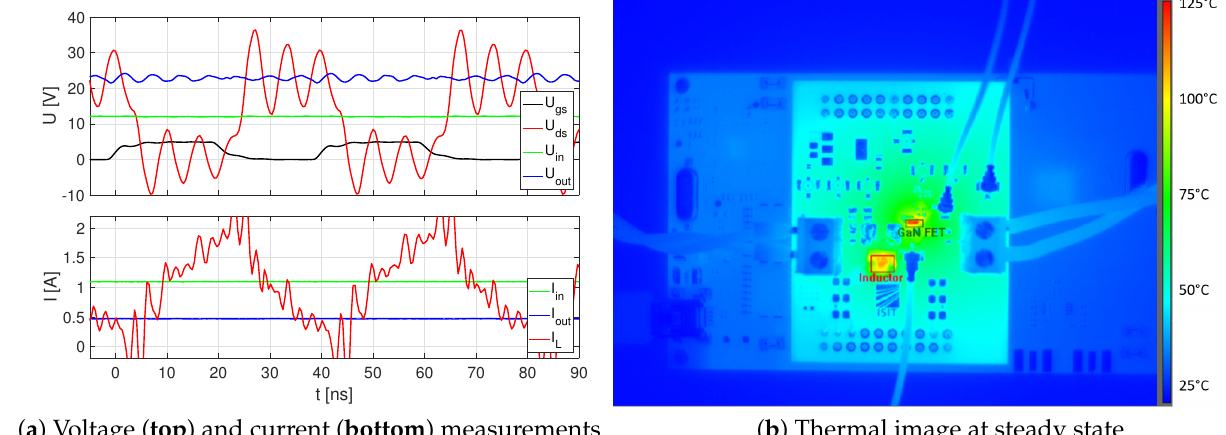
Figure 14. Measurement results of DC/DC converter at U in = 12V.